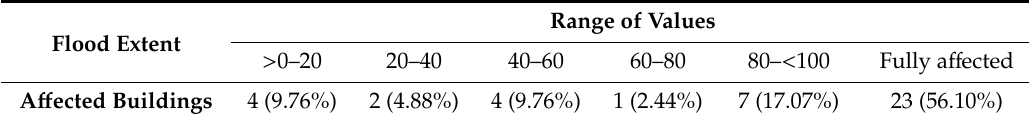
Table 3. Number of a ff ected building distributed by ranges of the a ff ected extent.